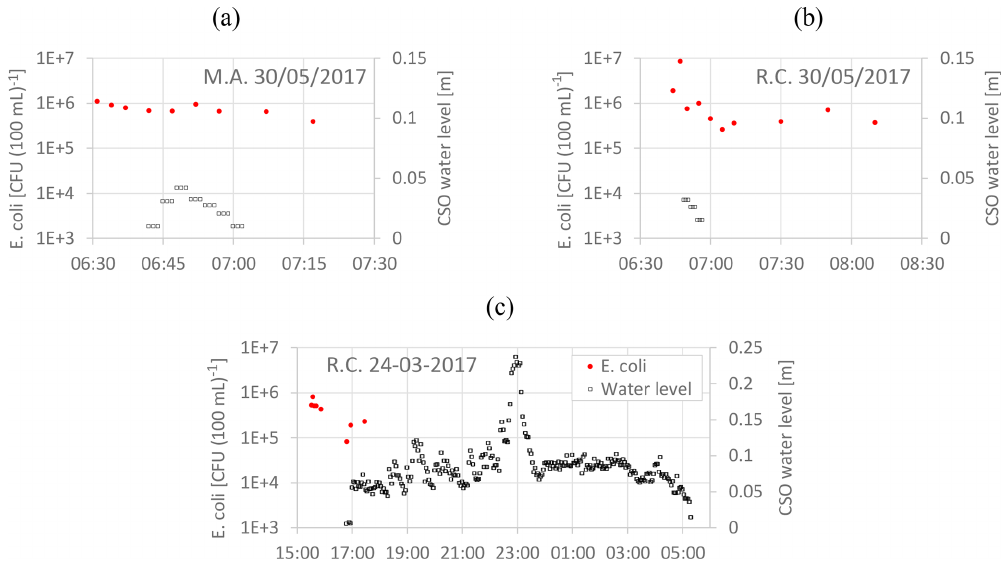
Figure 3. E. coli concentration and CSO water level measured at the two CSO structures of Riera Canyadó (R.C.) and Maria Auxiliadora